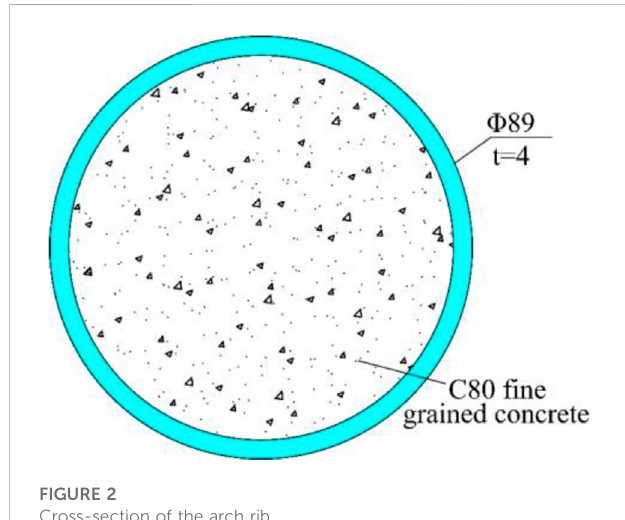
FIGURE 2 Cross-section of the arch rib.